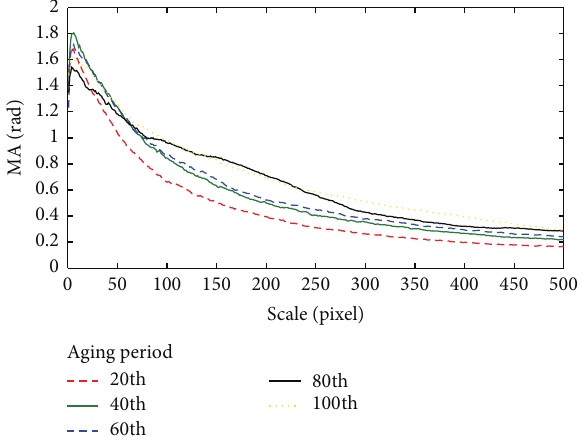
Figure 6: MA spectra of SEM image samples of the composites in 5 different aging periods.